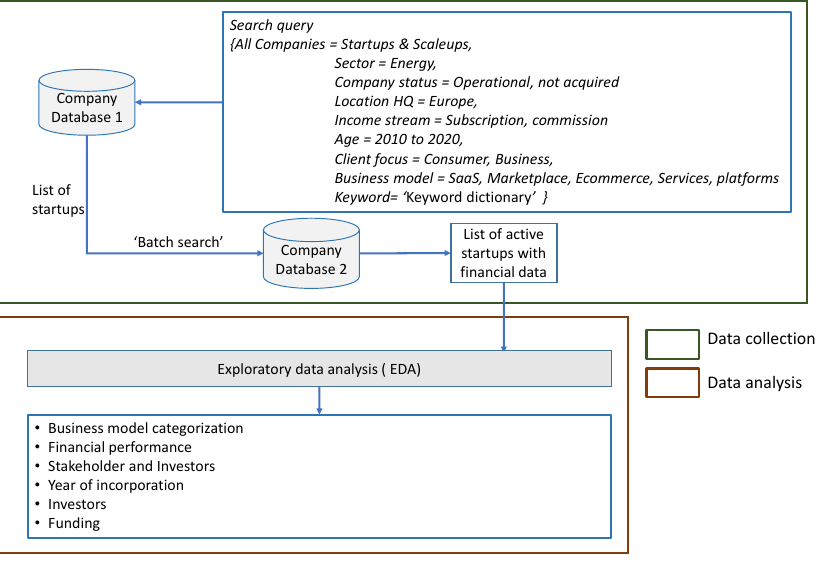
Figure 3. Data collection and